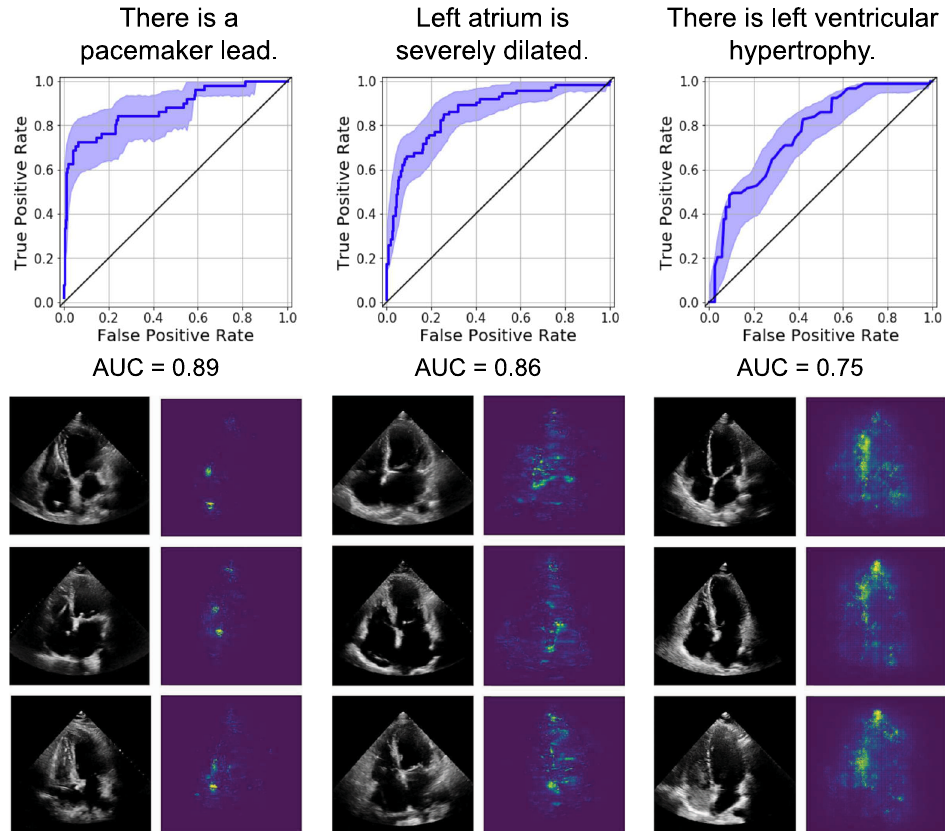
Fig. 2 EchoNet performance and interpretation for three clinical interpretations of local structures and features. For each task, representative positive examples are shown side-by-side with regions of interest from the respective model. Shaded areas indicate 95 % con fi dence